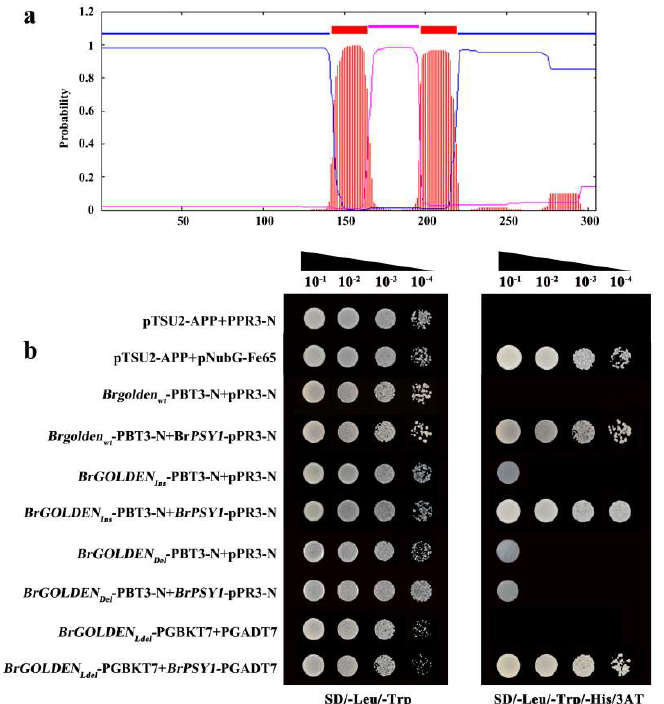
Figure 10. Interactions of BrPSY1 with BrGOLDEN. ( a ) Prediction of transmembrane helices in Brgolden wt . The red line represents the transmembrane. The blue line represents the inside. The pink line represents the outside. Positions 142–164 and 197–219 amino acids represent transmembrane helices. The abscissa indicates the amino acid site. ( b ) Co−transformation of prey and bait vectors in various combinations validates protein interactions. Co−transformation of pPR3−N and pTSU2−App vectors was used as a negative control and co−transformation of pTSU2−APP and pNubG−Fe65 vectors was used as a positive control. Dilutions (1–10 −4 ) of different concentrations of the saturated cultures were spo(cid:308)ed onto SD/−Leu/−Trp/−His/−3AT plates.